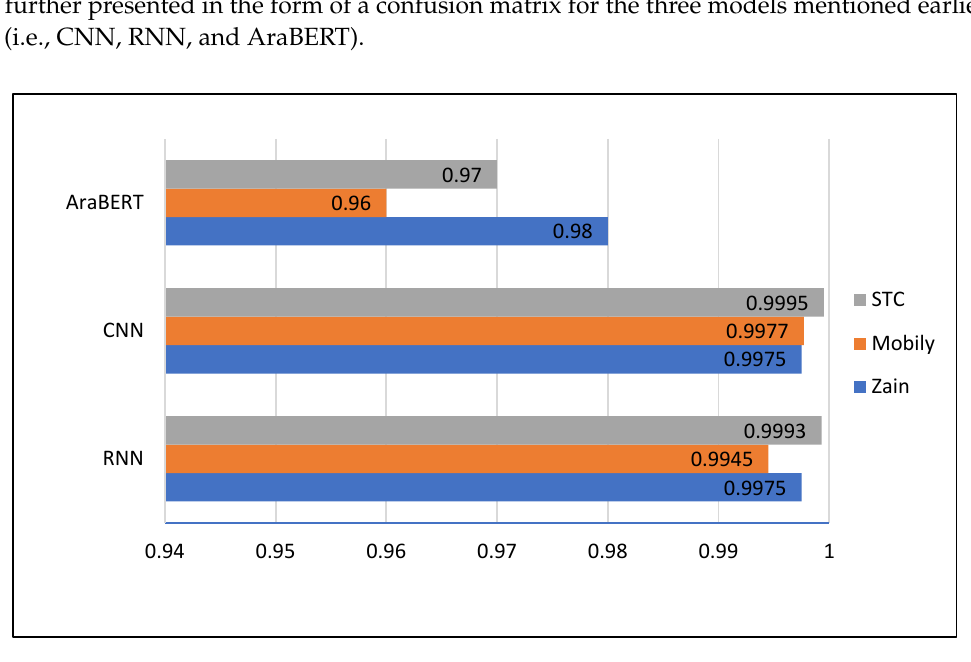
Figure 8. Training accuracies obtained by RNN, CNN, and AraBERT.